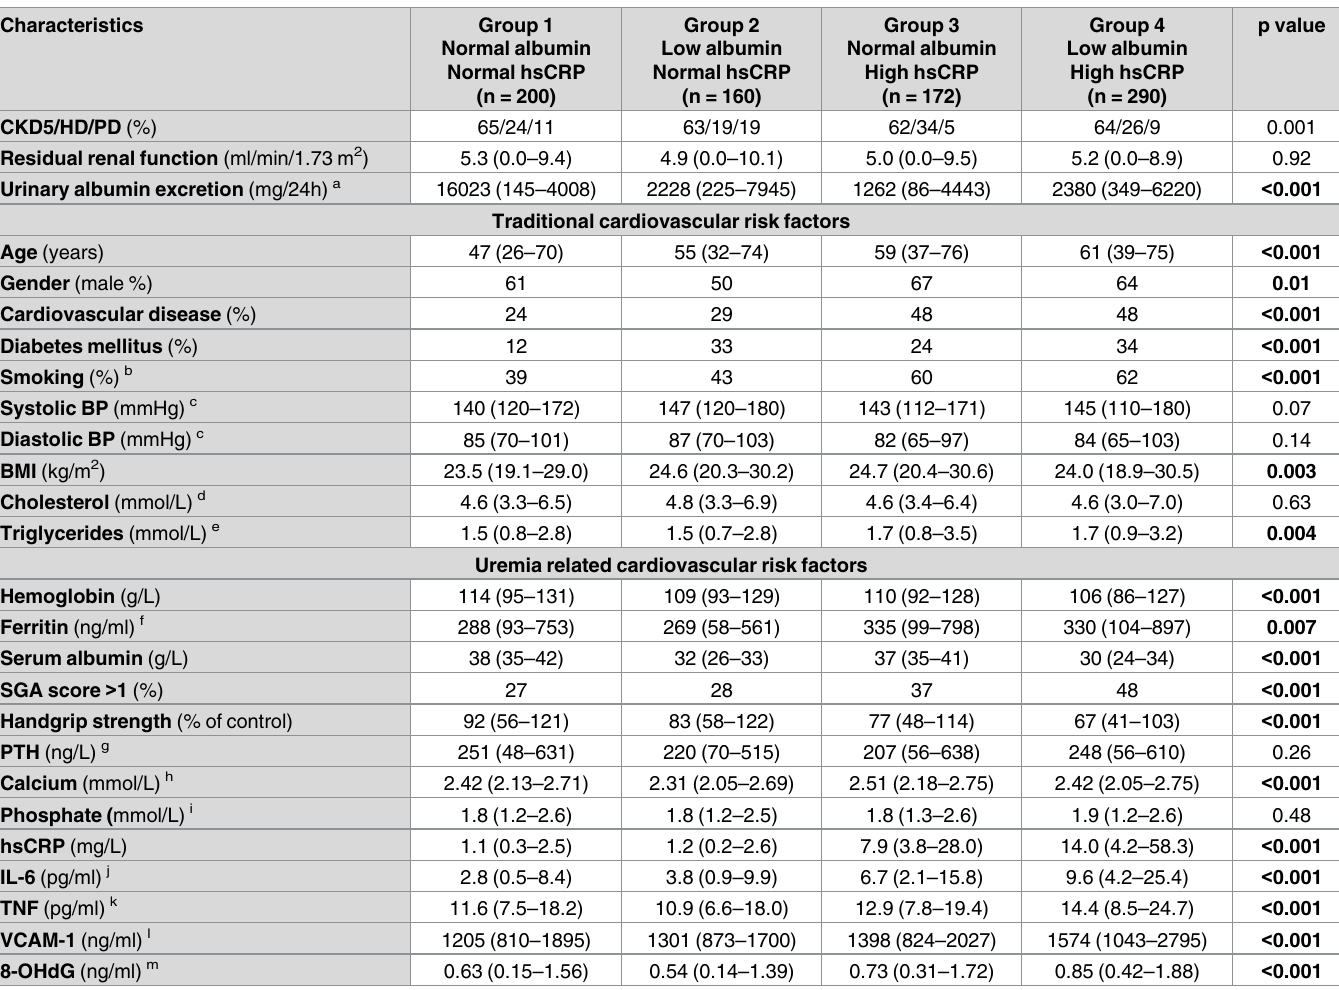
Table 1. Demographic, clinical and laboratory characteristics of 822 CKD stage 5 patients divided into four groups defined according to levels of serum albumin and